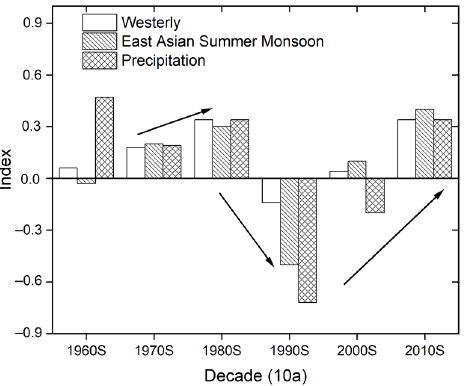
Figure Figure 10. Interdecadal changes of westerly wind, east asian summer monsoon, and precipitation indices.